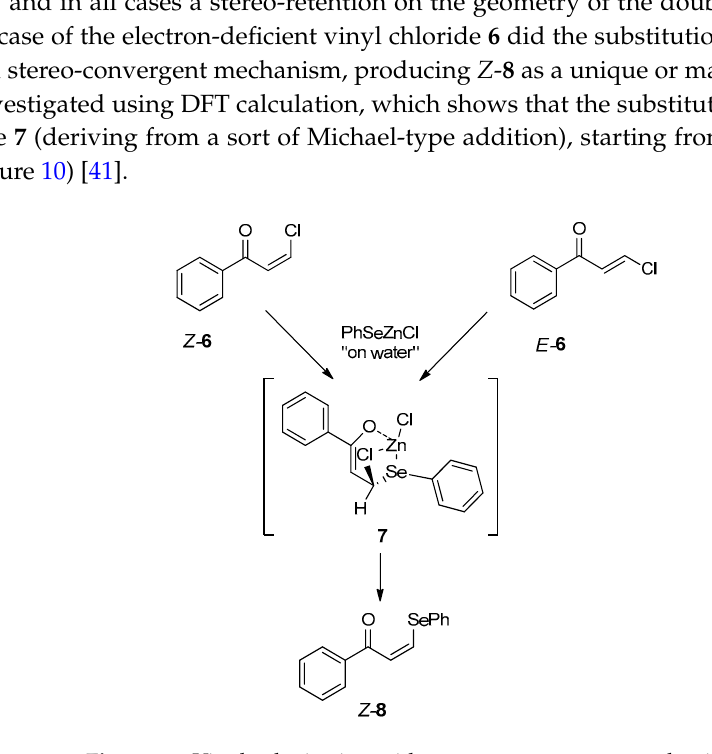
“on-water” conditions (r.t., 2 h).